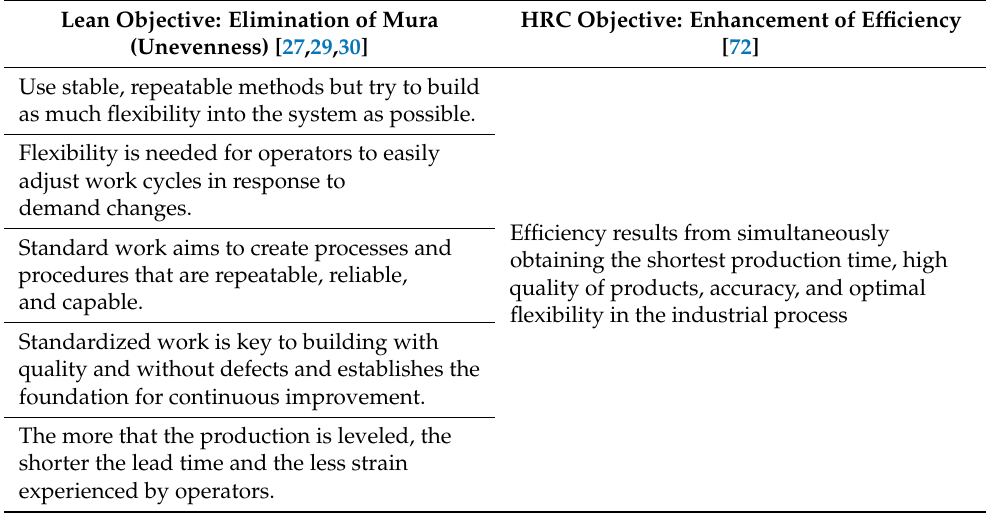
Table 2. Comparison of scope between lean’s goal for Mura elimination and HRC’s goal for im- proved